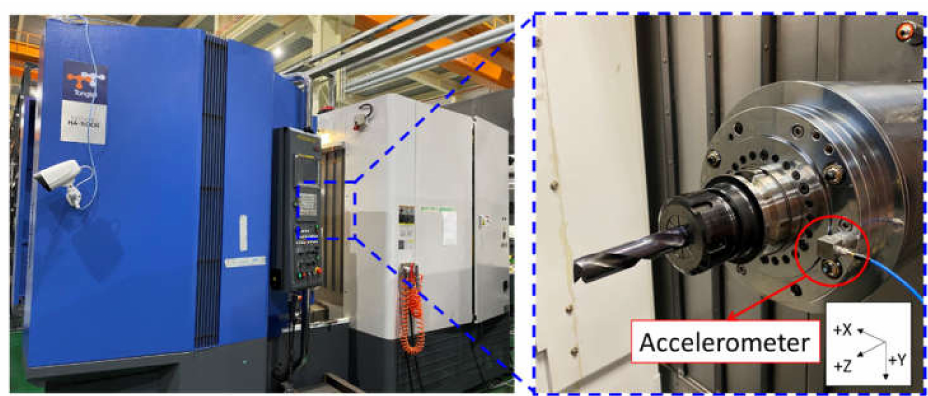
Figure 5. Experimental machine and accelerometer setup.